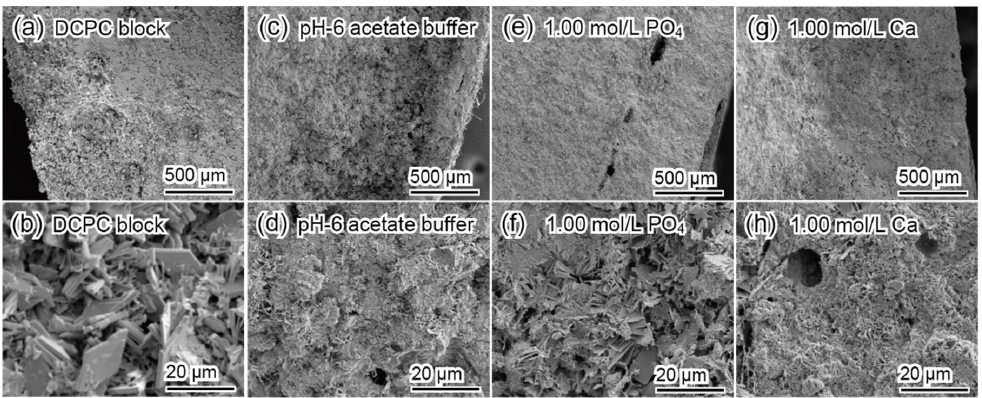
adjusted solution, ( e , f ) pH-6 adjusted 1.00 mol/L PO 4 solution, and ( g , h ) pH-6 adjusted 1.00 mol/L Ca solution, each at 70 ◦ C for 2